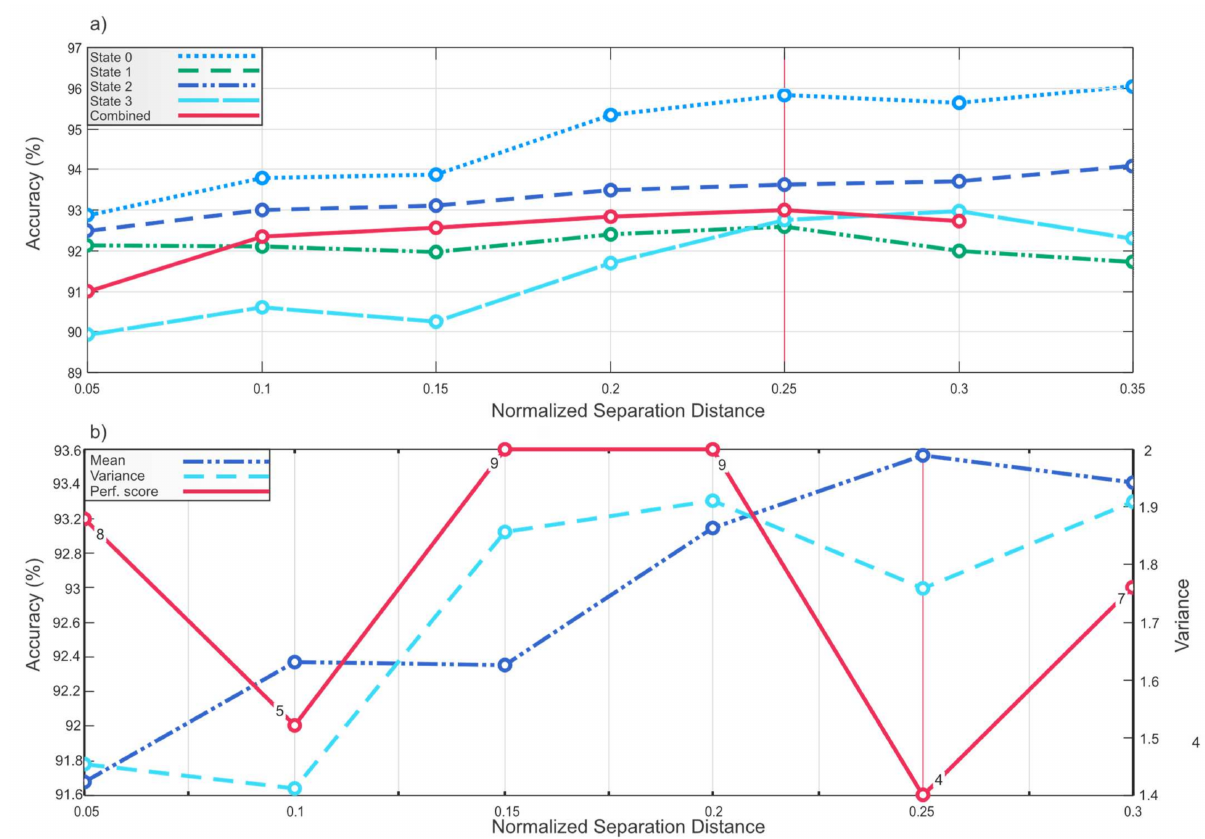
Figure 13. Classification accuracy and NSD value plot; ( a ) Mean value and variance of the classification accuracy for each 0.05 iteration of NSD; ( b ) Accuracy means, variances, and performance